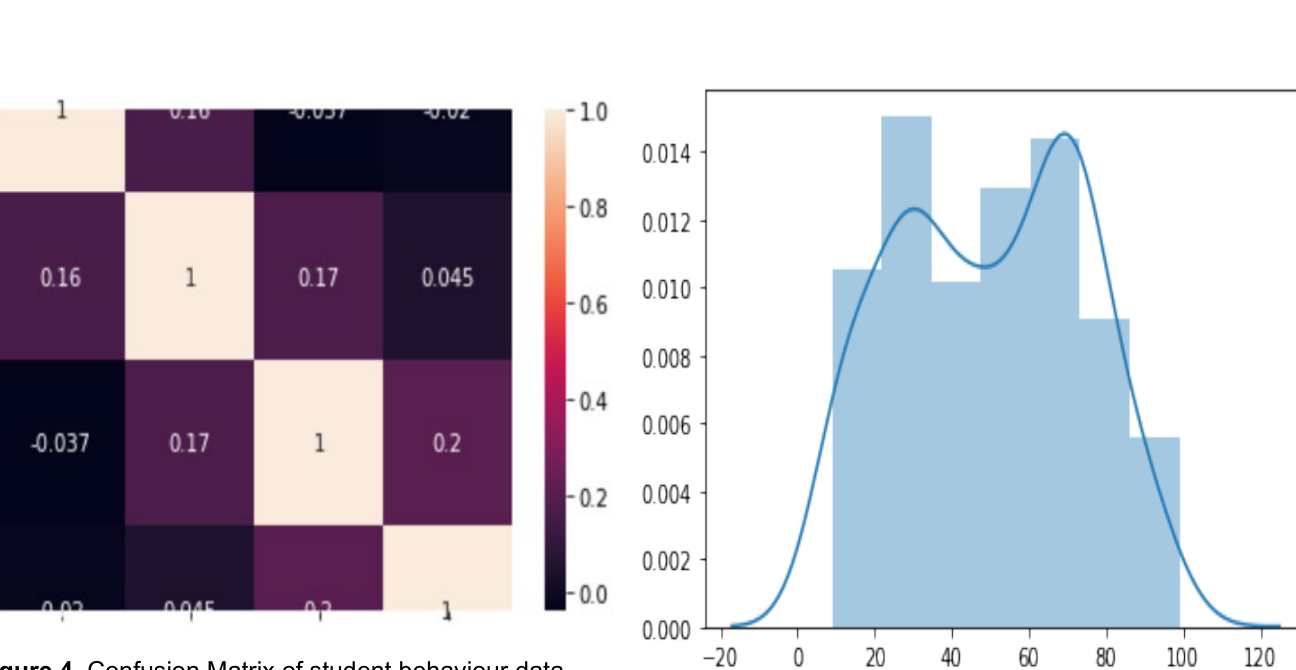
Figu re 4. Confusion Matrix of student behaviour data